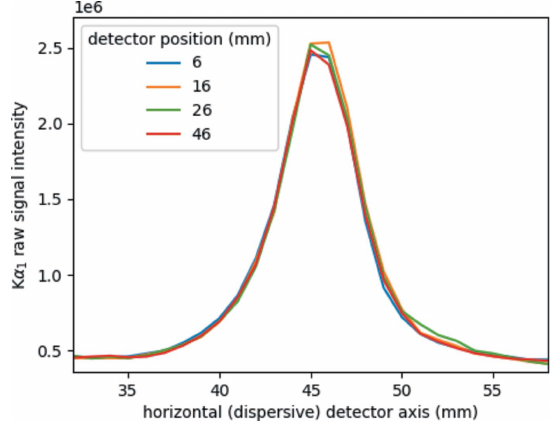
Figure 10 Cu K (cid:2) spectrum of a metallic Cu foil recorded by von Ha´mos spectrometers with cylindrical (red) and conical (blue) analyzer crystals.